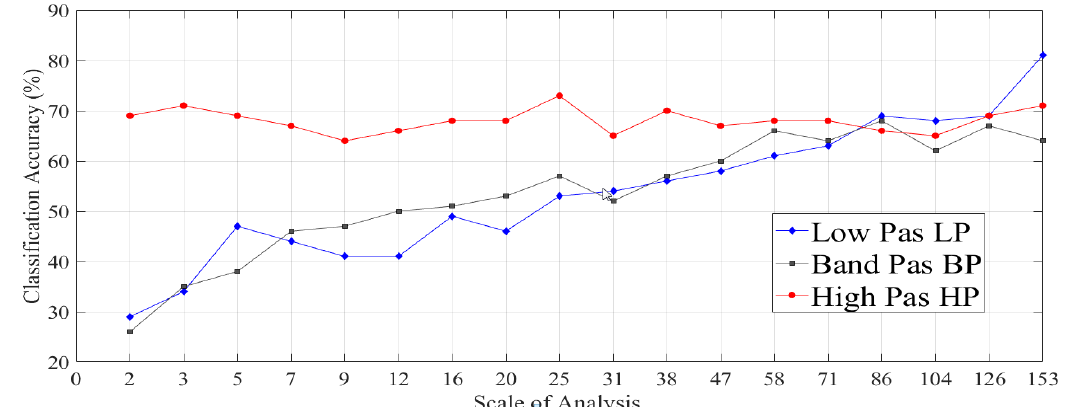
Figure 25. Comparison between the achieved accuracy averages for three different filtered image data sets: LP, BP, and HP data set at all available scales of analysis.